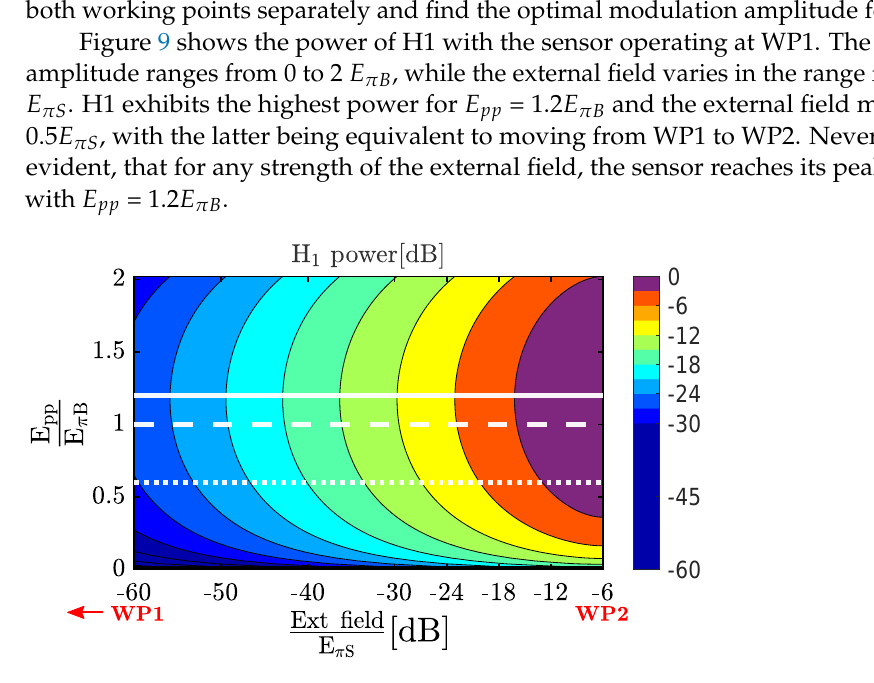
Figure 9. H1 power as a function of the external electric field and modulation amplitude. The solid, dashed and dotted lines indicates H1 power at constant amplitude modulation E pp = 2, 1.5, 0.6 E π B